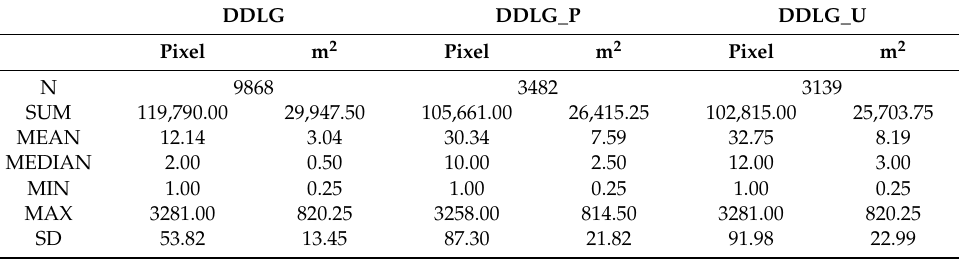
Table 6. Classification results per class in number and percent (%) of pixels (0.5 × 0.5 m) for the three classification scenarios: Random forest (RF) classification (DDLG), RF classification with post-processing (DDLG_P), and with additional deadwood-uncertainty filter (DDLG_U). Table 7. Classification results for deadwood patches (clumps of pixels classified “dead”) expressed in the number of pixels (size 0.5 × 0.5 m) per classification scenario: Random forest (RF) classification (DDLG), RF classification with post-processing (DDLG_P), and with “deadwood-uncertainty” filter